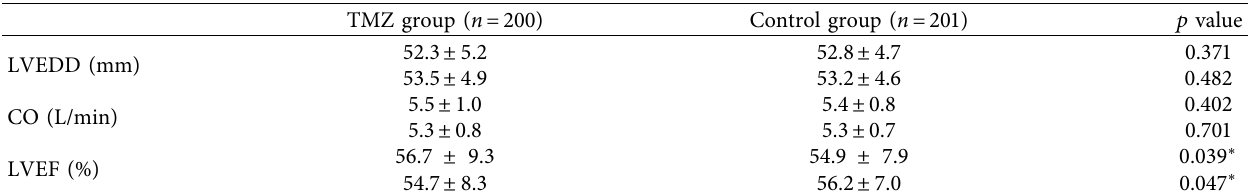
All comparisons were two-tailed, and ∗ p < 0 . 05 was considered statistically significant. Table 5: Inhospital (10–14 days) and postdischarge (6 months) echocardiograms indexes ( x ± s).